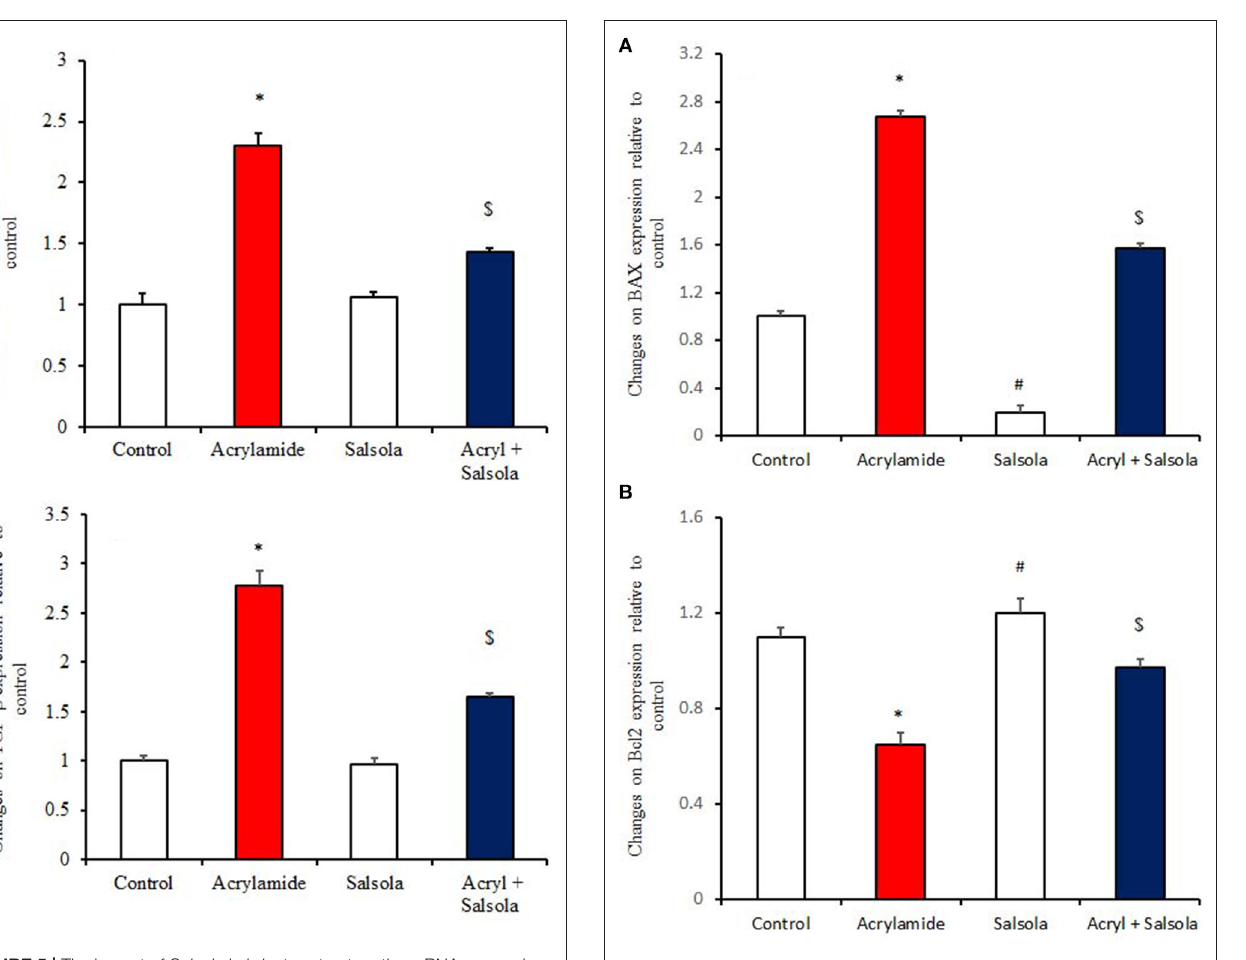
FIGURE 6 | The impact of Salsola imbricata extract on the mRNA expression of Bax and Bcl2 in acrylamide-administered rats ( n = 10). Graphic presentation of hepatic expression according to qRT-PCR analysis of Bax and Bcl2 in different groups of rats after normalization with the housekeeping gene (actin). * p < 0.05 vs. the control group; # p < 0.05 vs. the other groups; $ p < 0.05 vs. the acrylamide-administered